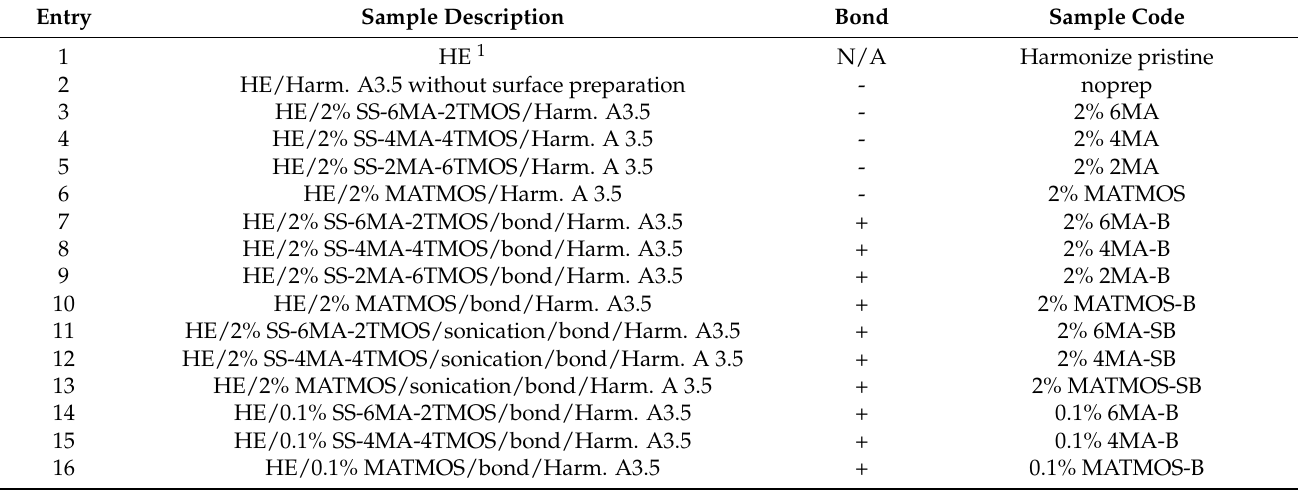
Table 1. Samples prepared for